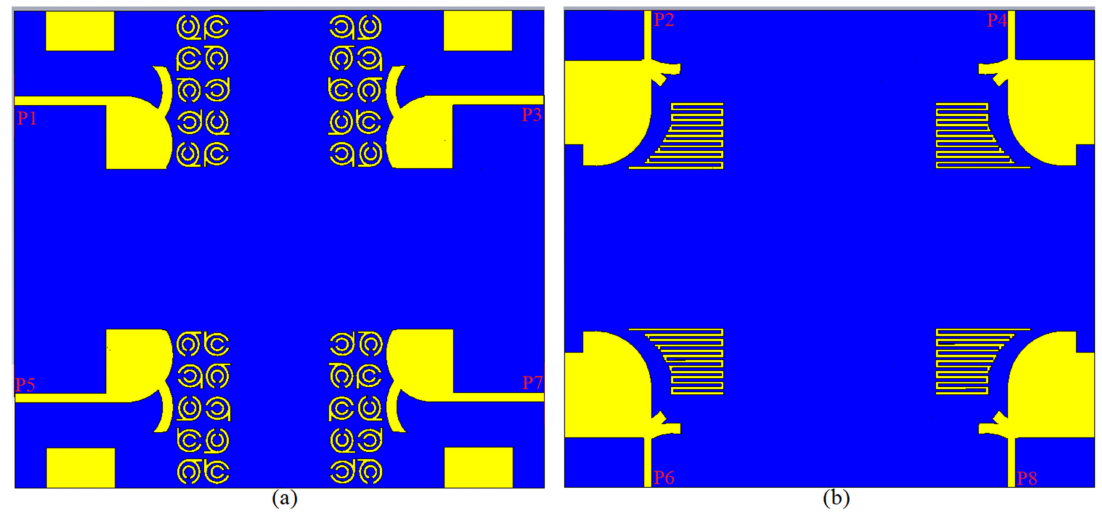
Figure 18. The MIMO antenna on a denim flexible board: ( a ) 2D front view, ( b ) back view.